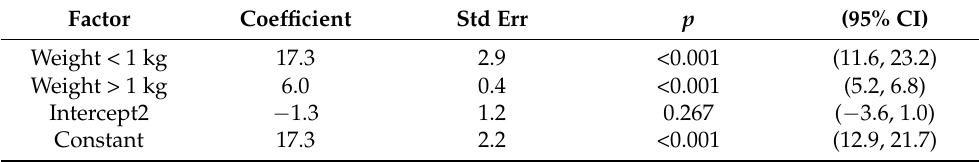
Table 1. Segmented linear regression of tracheal length (mm) on weight, with a node at 1 kg 1